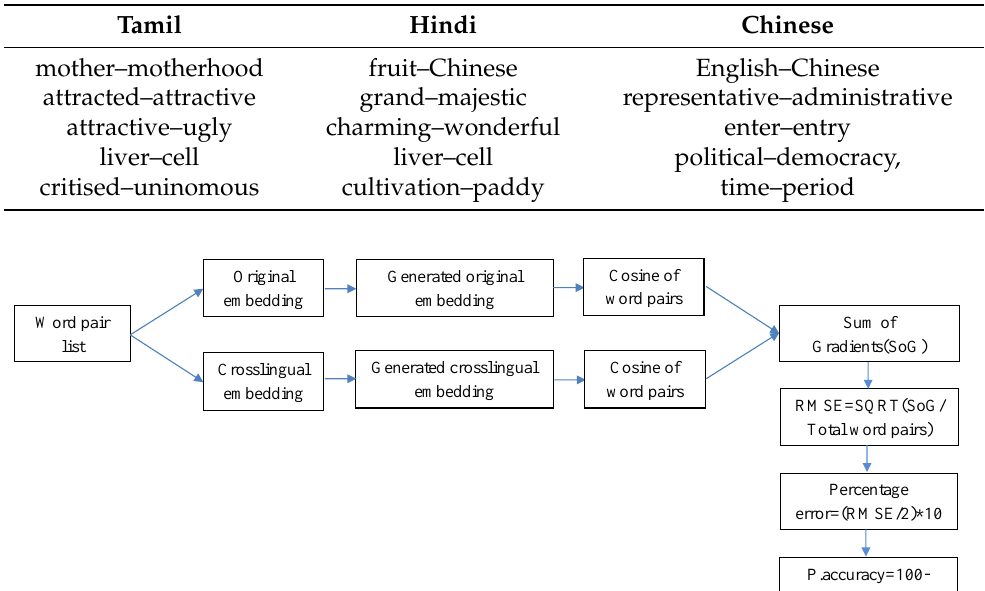
Table 2. A sample word pairs list for computing pairwise cosine accuracy for all three evaluating languages.